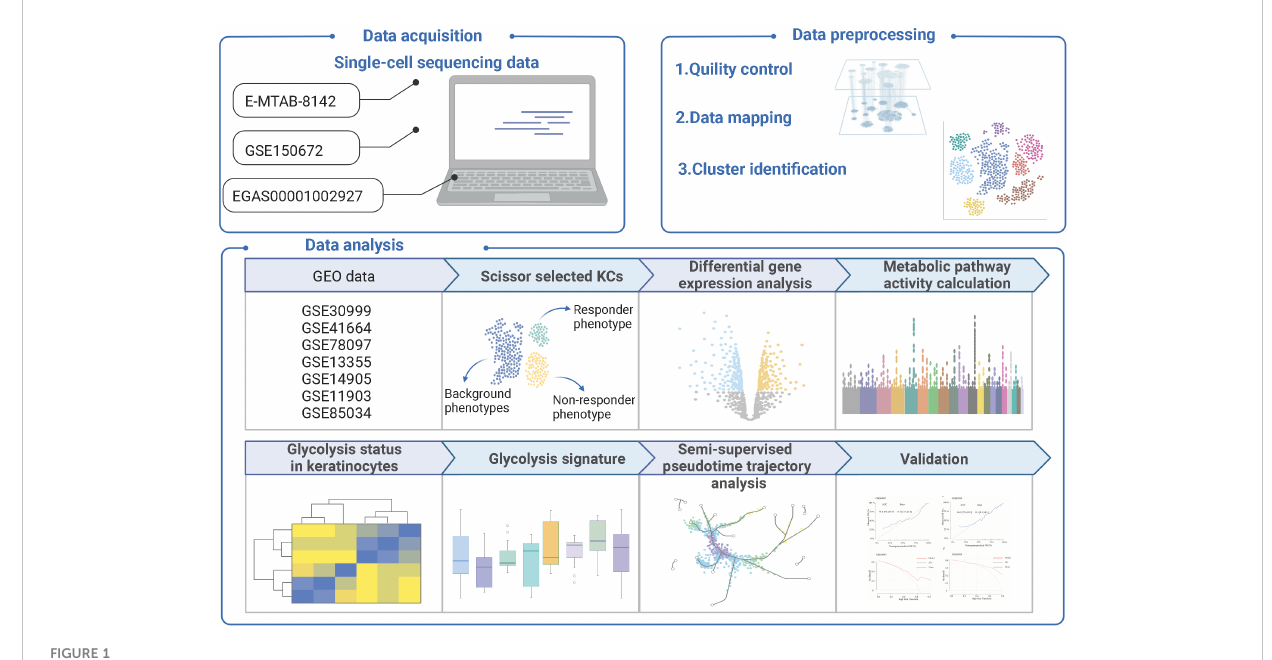
FIGURE 1 The fl owchart of the